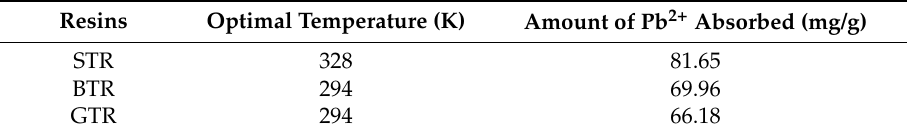
Table 3. The kinetics constants for the adsorption of Pb 2+ (Resin: 0.5 g/L; C i : 100 ppm; particle size + 100 μ m; temperature: 303 K; agitation rate: 120 rpm; contact time: 180 min; pH 6. Pseudo ‐ First ‐ Order Equation Pseudo ‐ Second ‐ Order Equation Resins (cid:2199) (cid:2187),(cid:2187)(cid:2206)(cid:2198) (mg/g)